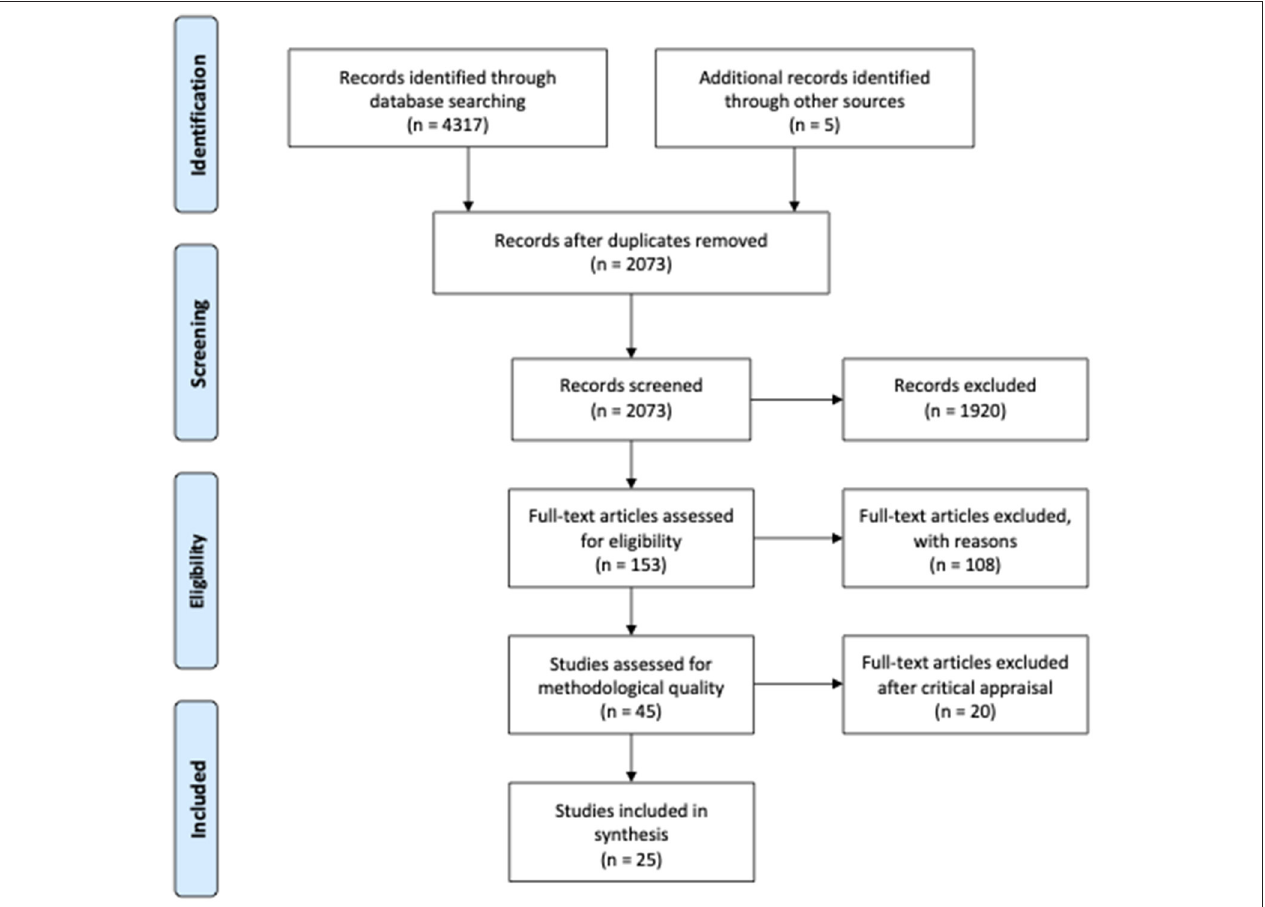
FIGURE 1 | PRISMA flow